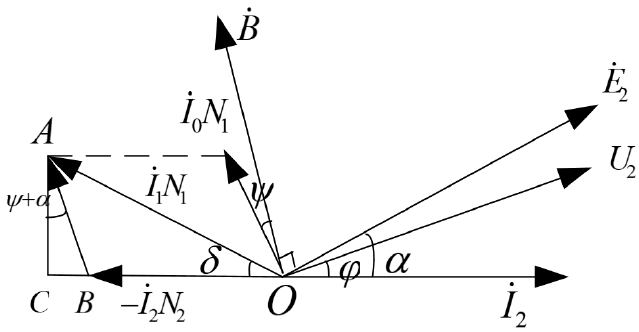
Figure 4. Error analysis vector diagram of the current sensor. Here, α is mainly determined by the impedance angle of the cement-based